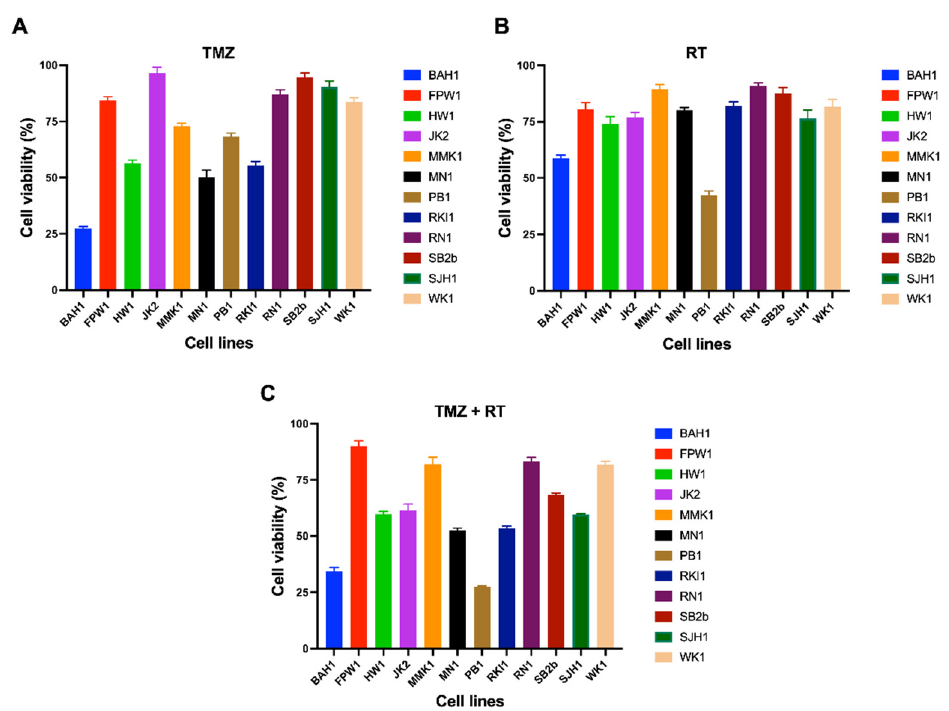
Figure 4. Cell viability of 12 patient-derived glioblastoma cell lines treated with TMZ ( A ), RT ( B ) or TMZ + RT ( C ). Cell lines were treated with a clinically relevant dose of TMZ (35 µM) and/or RT (2 Gy), grown as adherent cultures for 7 days before being assessed for cell viability with an MTT assay. Data points represent the mean and SEM of three biological replicates over three independent experiments.